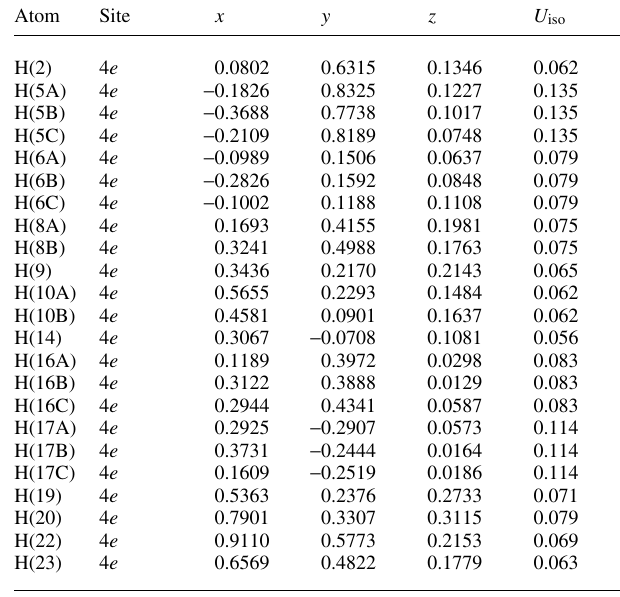
Table 2. Atomic coordinates and displacement parameters (in Å 2 ) .